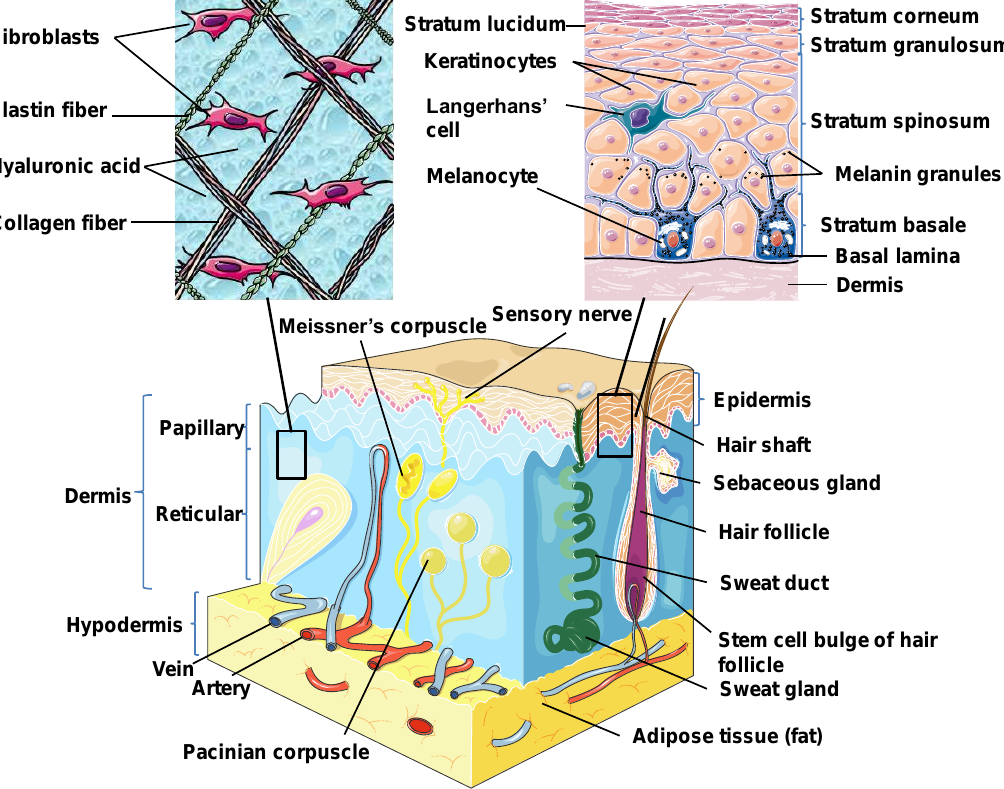
Figure 1. Skin structure. Schematic diagram showing the structural components of the normal human skin. This figure was created using images from Servier Medical Art Commons Attribution 3.0 Unported License (http: // smart.servier.com). Servier Medical Art by Servier is licensed under